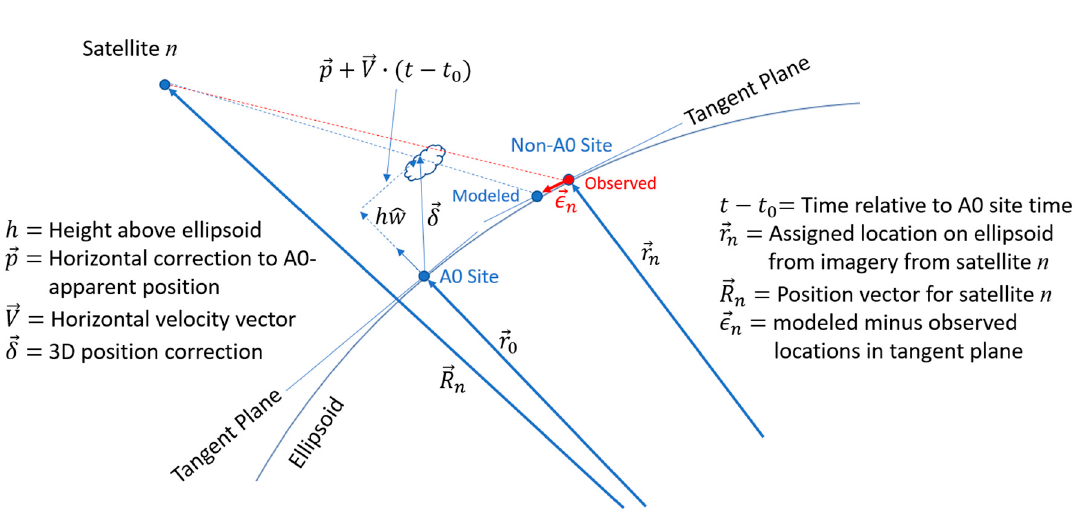
Figure 3. The states 𝑋 = (ℎ,𝑝⃗,𝑉(cid:4652)⃗) model the position of the tracked feature relative to its apparent location (“A0 Site”) as seen in the A0 imagery, with the optimal state being the one the makes the modeled distance from each observed site minimum in a least-squares sense.